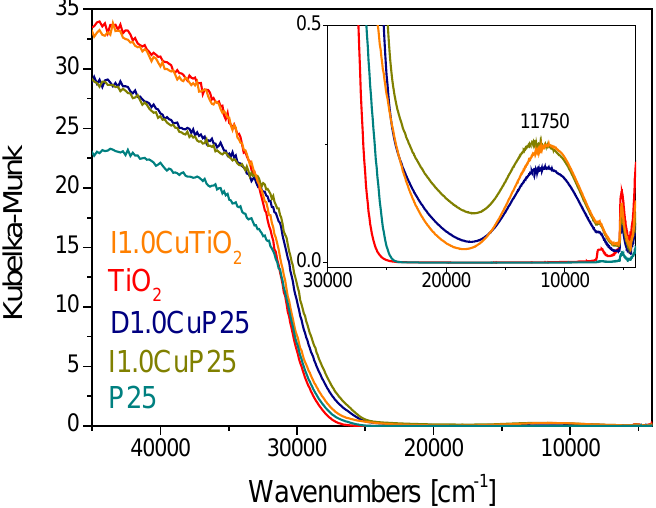
Figure 7. DR UV-Vis-NIR spectra collected on the photocatalysts. Inset: zoom on the absorption band at 11300 cm − 1 . The spectra related to bare P25 and TiO 2 are also reported for the sake of comparison. The band observed for the CP sample (D1.0Cu / P25, blue curve) has the lowest intensity and is A comparison between the FTIR spectra collected on I1.0Cu/P25 and D1.0Cu/P25 in the whole − 1 shifted to 11500 cm , indicating that di ff erent copper species, likely to be characterized by a lower energy transition, are formed by CP